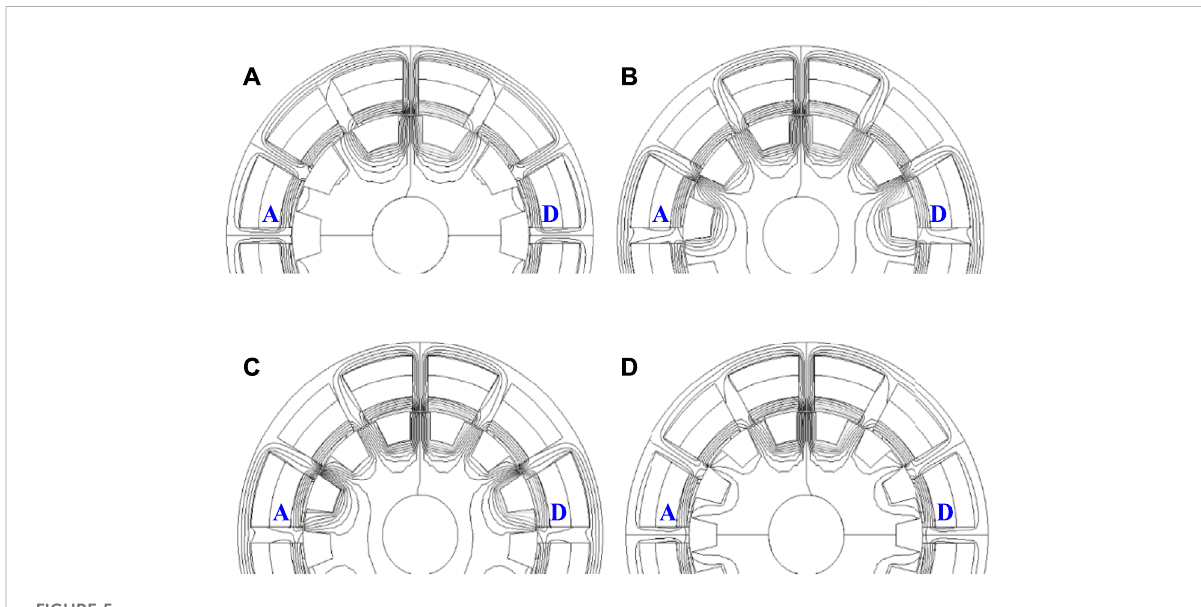
FIGURE 5 Flux distribution generated by DC fi eld coils and dual-layer ferrite PMs (A) 12/10. (B) 12/11. (C) 12/13. (D) 12/14.